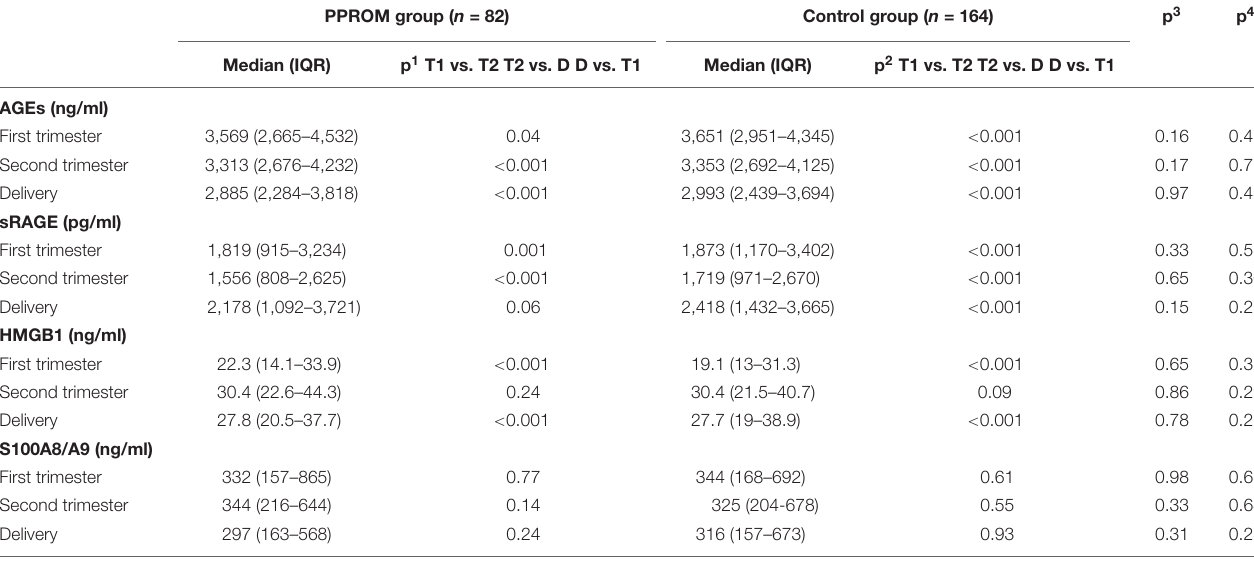
TABLE 2 | Median AGEs, sRAGE, HMGB1, and S100A8/A9 plasma concentrations from 82 women in the PPROM group and 164 women in the control group at three points: first trimester (T1), second trimester (T2), and delivery (D). PPROM group ( n =